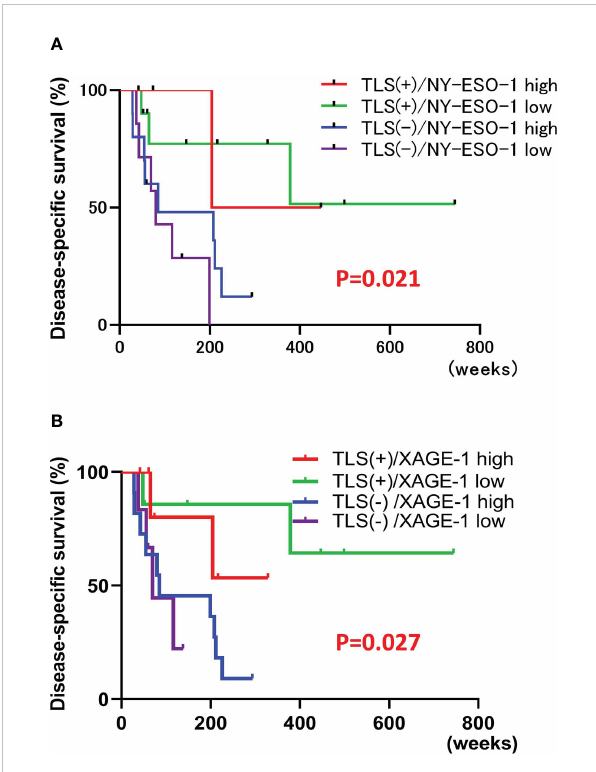
FIGURE 6 Correlation of each CTAs and TLS combination with prognosis. Kaplan-Meier survival curves for the patients classi fi ed by combination of NY-ESO-1 expression and the presence of TLSs in primary lesion using log-rank test (n=31, log-rank, p-value=0.021). TLS+/NY-ESO-1 high: 4 cases, TLS+/NY-ESO-1 low: 10 cases, TLS-/ NY-ESO-1 high: 10 cases, TLS-/NY-ESO-1 low: 7 cases (A) . Kaplan- Meier survival curves for the patients classi fi ed by combination of XAGE-1 expression and the presence of TLSs in primary lesion using log-rank test (n=31, log-rank, p-value=0.027). TLS+/XAGE-1 high: 7 cases, TLS+/XAGE-1 low: 7 cases, TLS-/XAGE-1 high: 11 cases, TLS-/ XAGE-1 low: 6 cases (B)